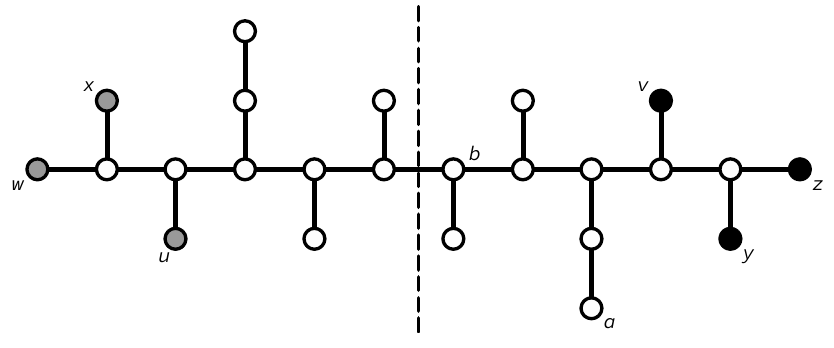
Fig. 12: Diagram showing T 3 . By symmetry, we assume Alice colors a vertex to the right of the dotted